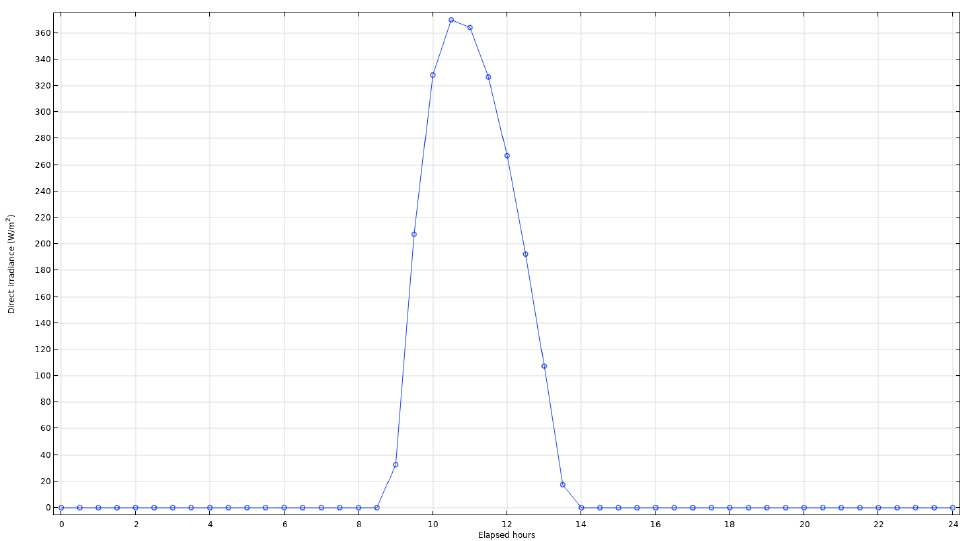
Figure 12. Direct Irradiance (Wm − 2 ) received by the cell at 2019’s winter solstice, referent to the boom’s east